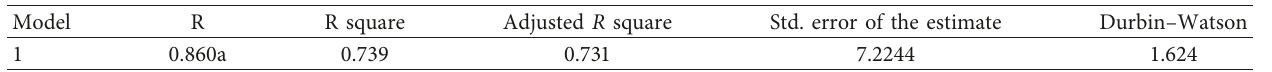
Table 4: The model summary.